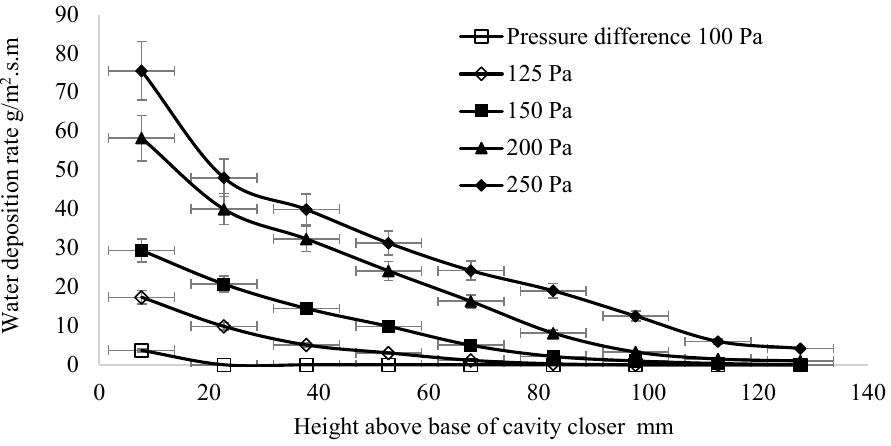
Figure 10. Deposition rate of water as a function of height above the cavity closer.